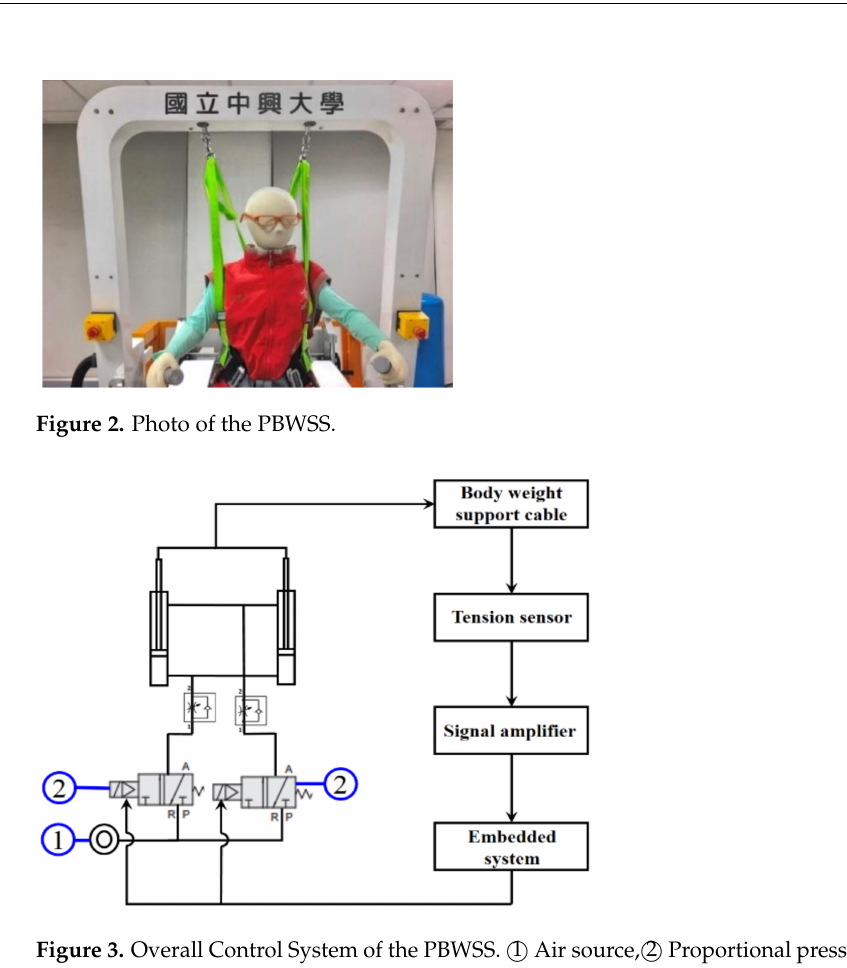
Figure 3. Overall Control System of the PBWSS. 1 (cid:13) Air source, 2 (cid:13) Proportional pressure control